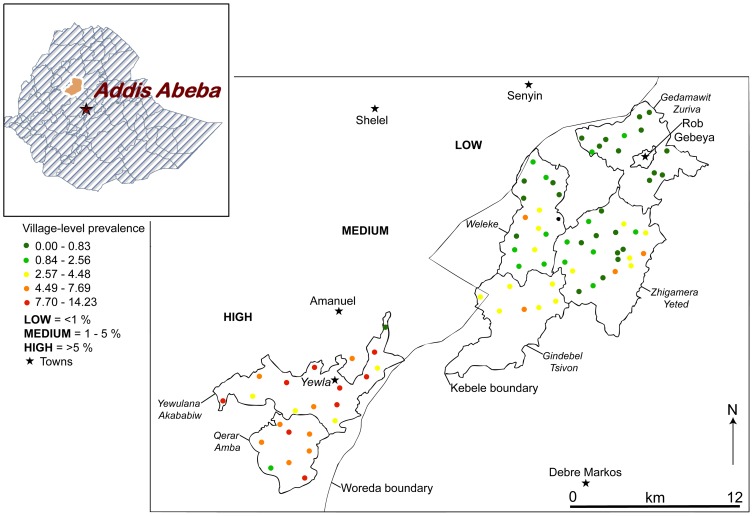
Study areas in east Gojam province in Ethiopia, and spatial patterns of village-level podoconiosis prevalence.